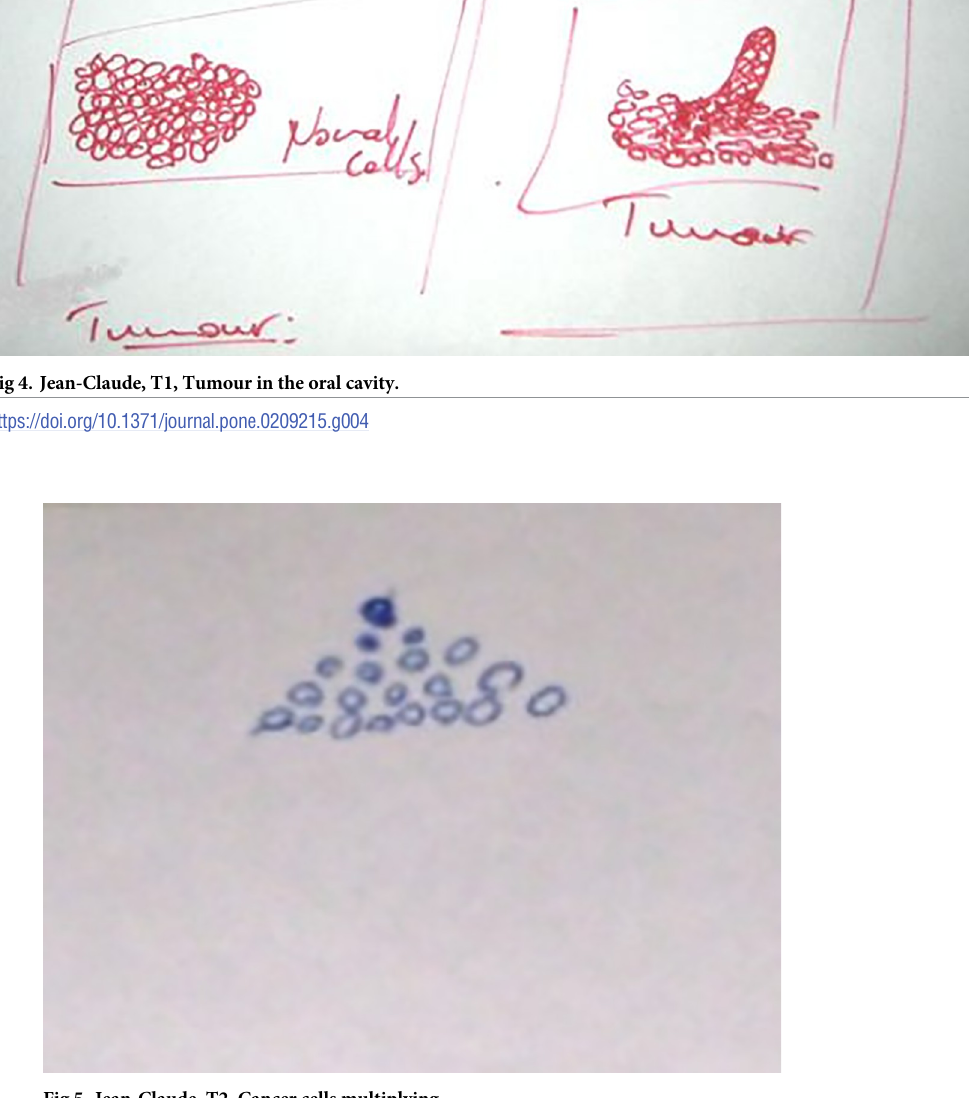
Fig 5. Jean-Claude, T2, Cancer cells multiplying.